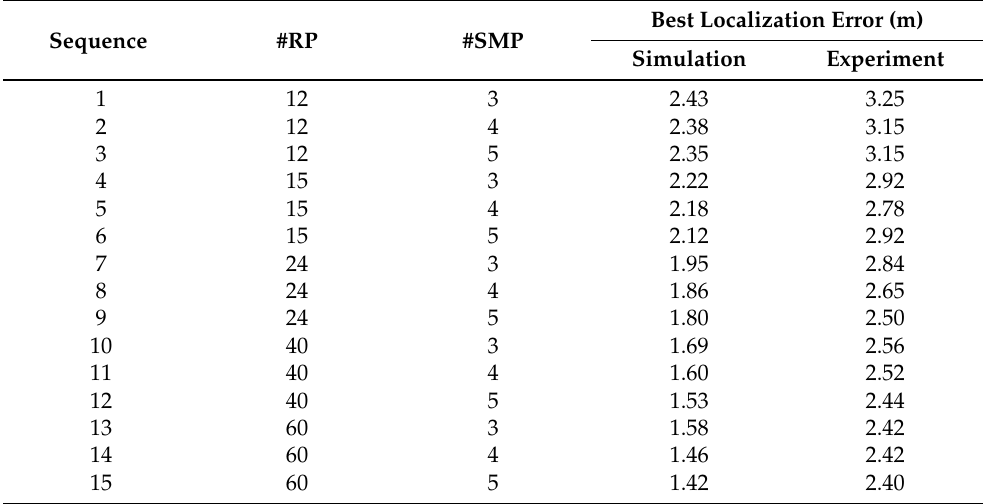
Table 5. 75% of cumulative error results–simulated and experimental–obtained for different configu- rations of 9